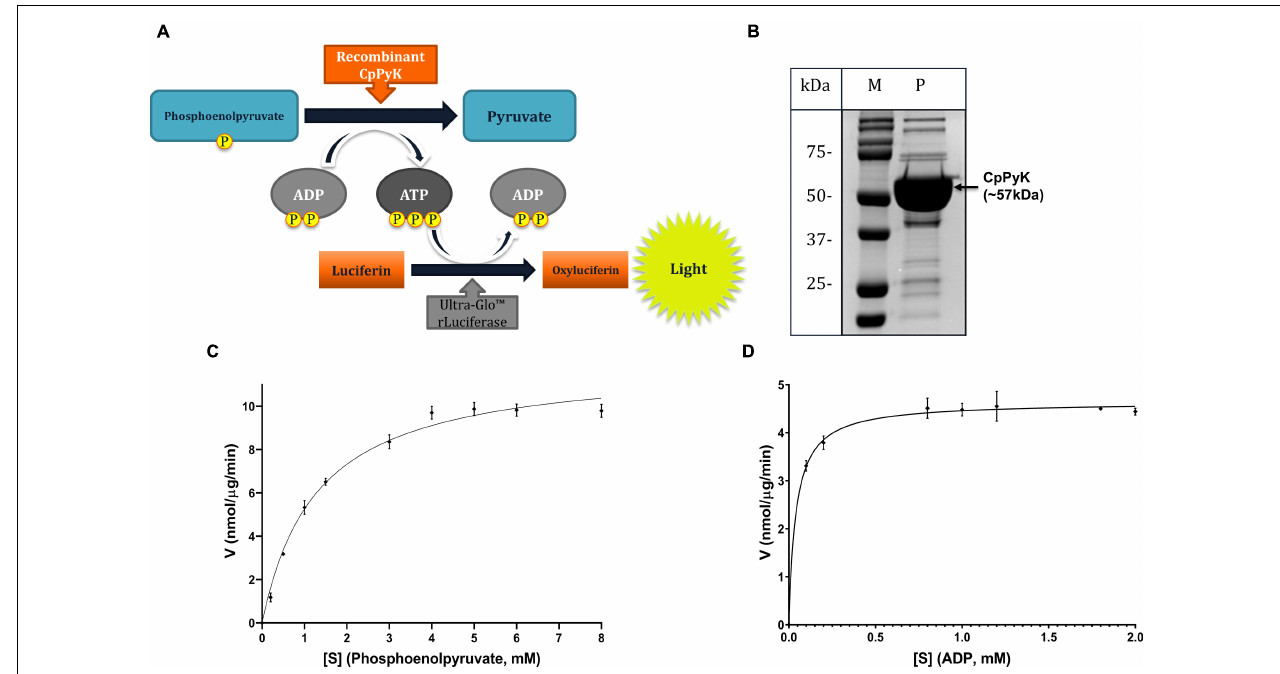
FIGURE 1 | Analysis of the enzymatic activity of rCpPyK protein. (A) Illustration of the in vitro assay for the dephosphorylation of phosphoenolpyruvate to pyruvate using rCpPyK protein as the catalytic enzyme. The reaction is coupled to a luciferase assay involving the utilization of the generated ATP to phosphorylate luciferin to oxyluciferin whose luminescence is detected by a plate reader. (B) SDS-PAGE analysis of the nickel affinity column chromatography purified rCpPyK protein stained with Coomassie blue (Lane M: protein ladder; Lane P: CpPyK protein with the expected band size indicated at about 57 kDa). (C,D) Enzyme kinetics of rCpPyK on the substrate phosphoenolpyruvate and on the co-substrate ADP, respectively. The data shown represent the mean of three independent experiments with standard deviation (SD) error bars. ADP, Adenosine diphosphate; ATP, Adenosine triphosphate; CpPyK, Cryptosporidium parvum pyruvate kinase; V, the velocity of the